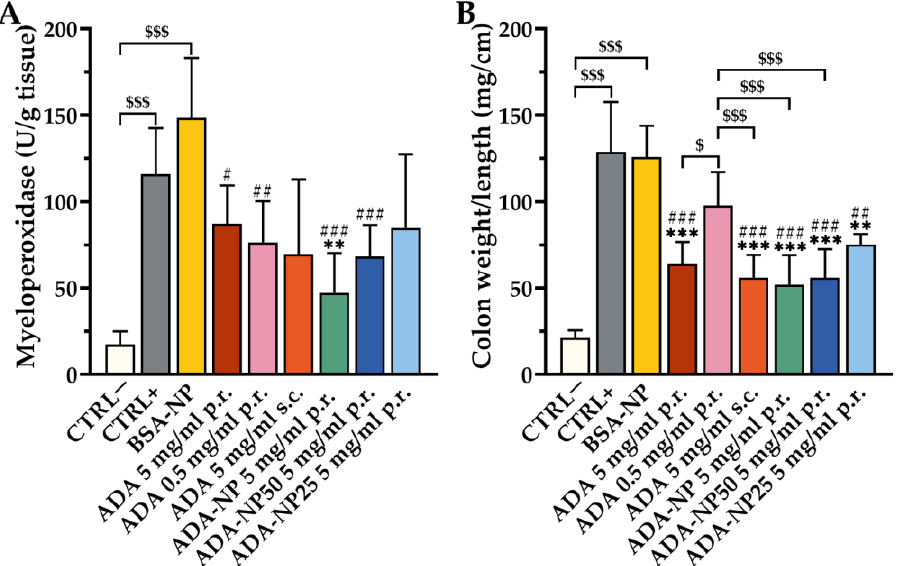
Figure 8. Anti-inflammatory effect of adalimumab (ADA) treatment on myeloperoxidase (MPO) activity and the colon weight/length ratio. Colitis was induced by rectal administration of TNBS (90 mg/kg body weight), and the mice were treated for 3 consecutive days. ( A ) MPO activity in colon tissue cells measured with MPO activity assay. ( B ) The colon weight/length ratio is represented as milligrams per centimeter of colon. Data are shown as mean ± SD ( n = 6). Statistical significance was assessed by one-way ANOVA followed by Tukey’s multiple comparisons test (** p < 0.01, *** p < 0.001 vs. CTRL+; # p < 0.05, ## p < 0.01, ### p < 0.001 vs. BSA-NP; $ p < 0.05, $$$ p < 0.001). ADA-NP, ADA conjugated nanoparticles with 100% surface loading rate; ADA-NP50, ADA conjugated nanoparticles with 50% surface loading rate; ADA-NP25, ADA conjugated nanoparticles with 25% surface loading rate; BSA, bovine serum albumin; BSA-NP, BSA conjugated nanoparticles; CTRL − , healthy control, CTRL+, colitis control.